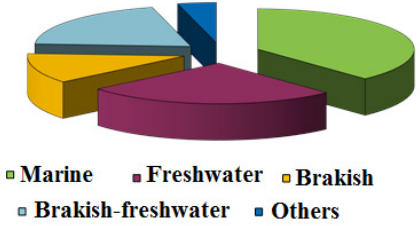
Figure 2. Distribution of phytoplankton in the eastern part of the Middle Caspian by ecological groups. The number of phytoplankton species per sample varied from 7 to 9. The highest species richness was found at depths from 50 to 100 m in Marin water with salinity 11.8–12.4‰ at depths 50–100 at a distance 90 km from the shore.